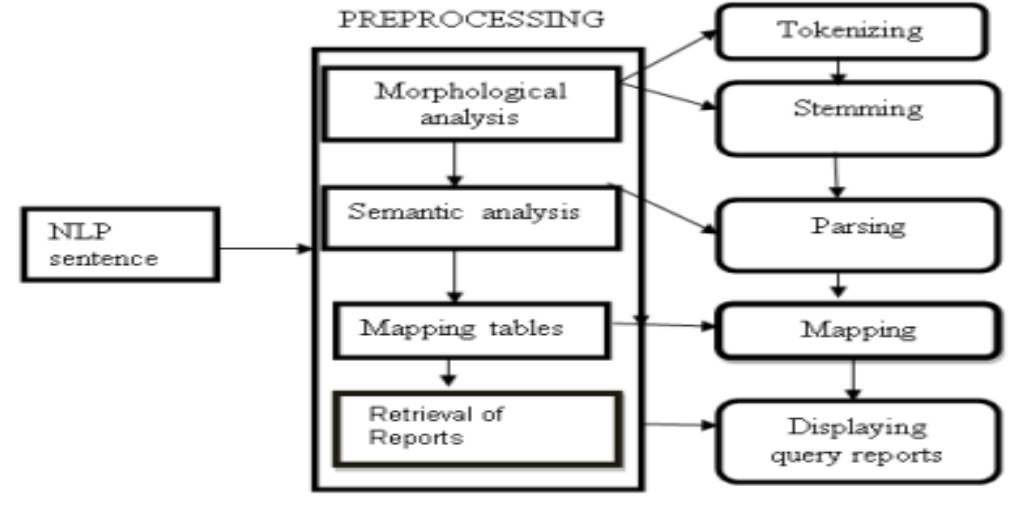
Figure 5 . Block diagram query conversion